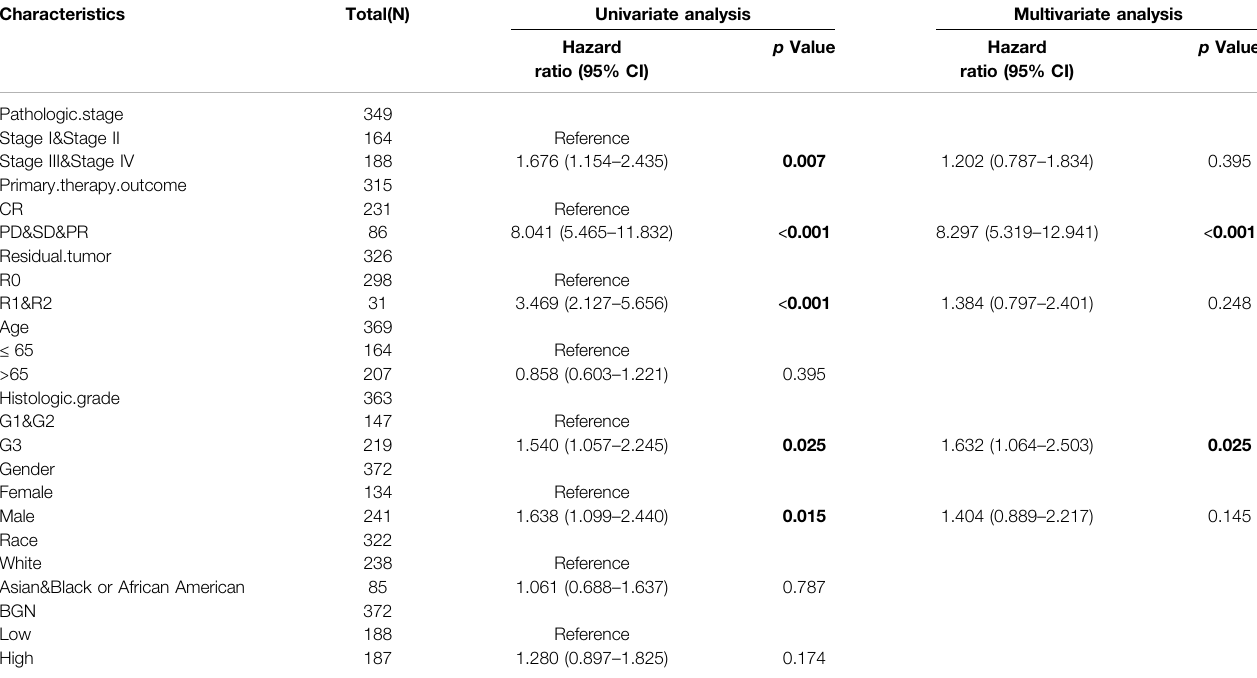
TABLE 8 | Univariate regression and multivariate survival method (Progress Free Interval) of prognostic covariates in patients with Gastric Cancer Characteristics